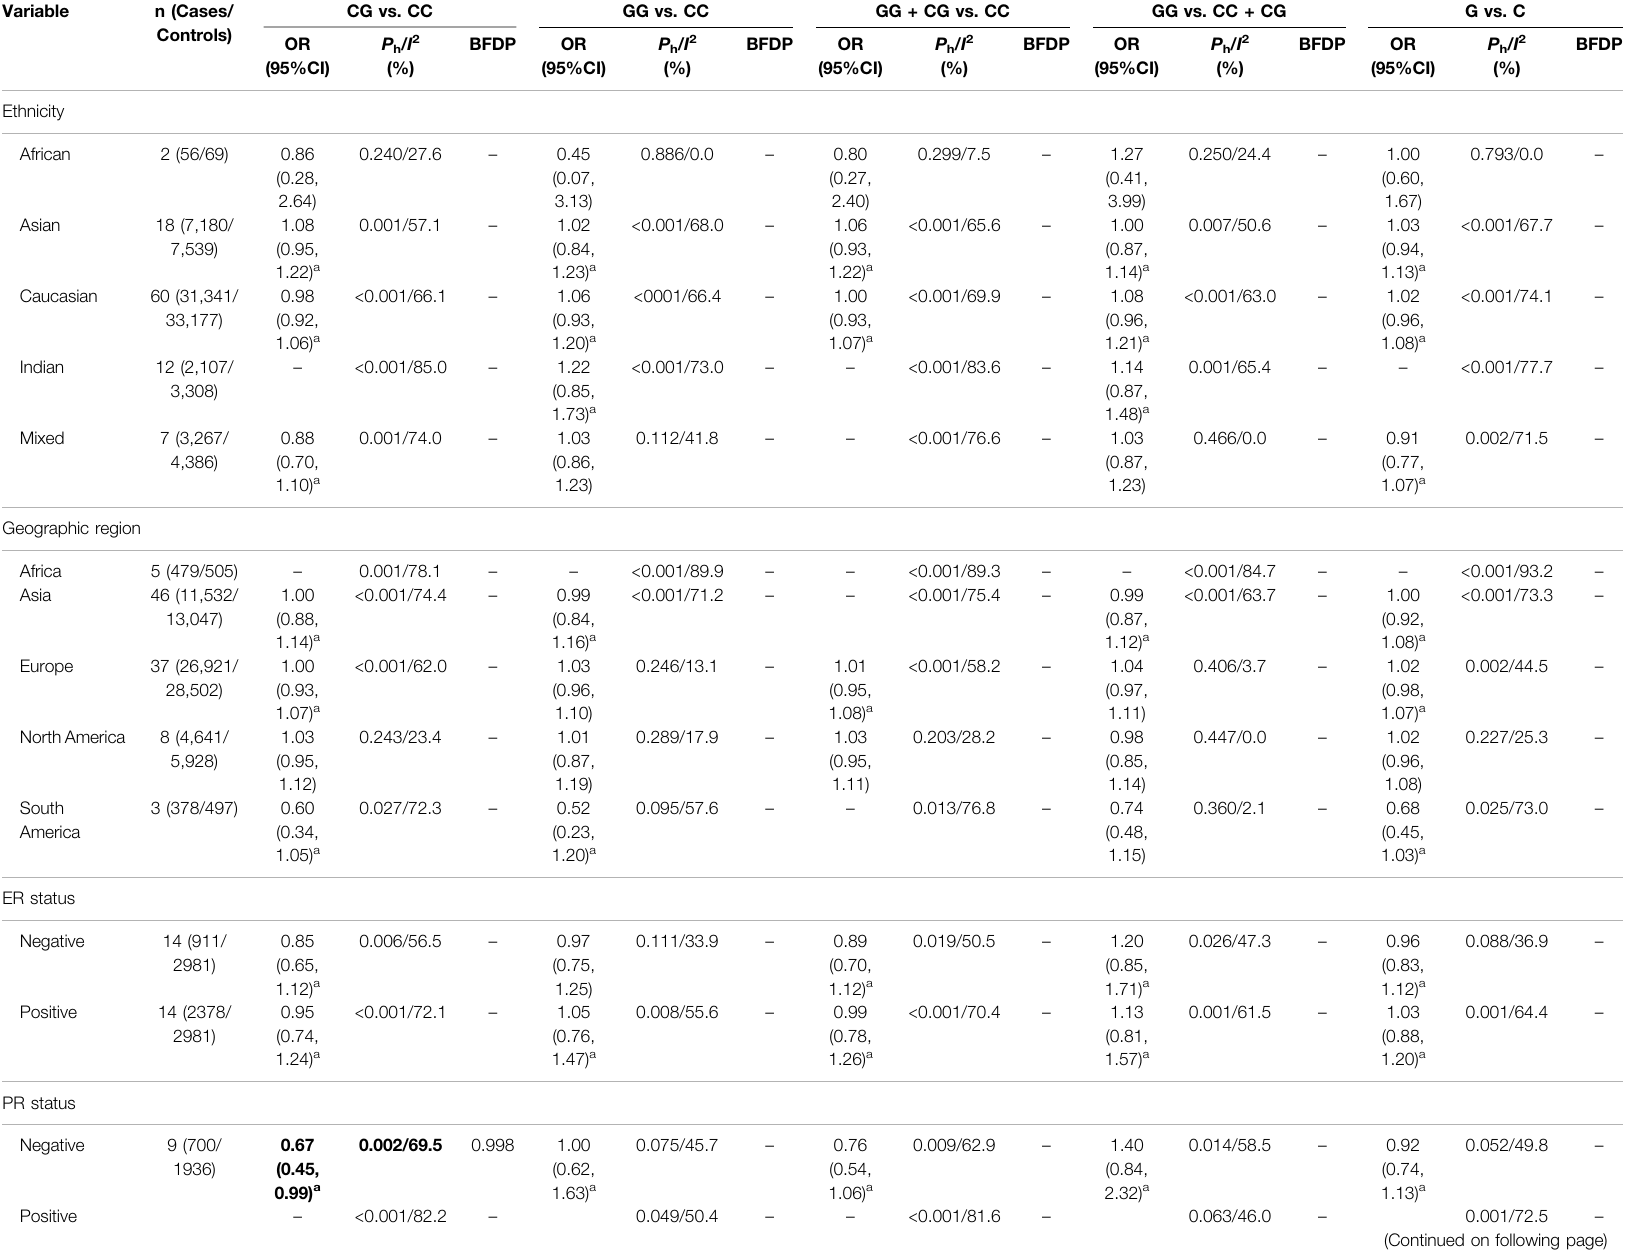
TABLE 2 | ( Continued ) Pooled results on the association between the TP53 codon 72 (rs1042522) polymorphism and BC